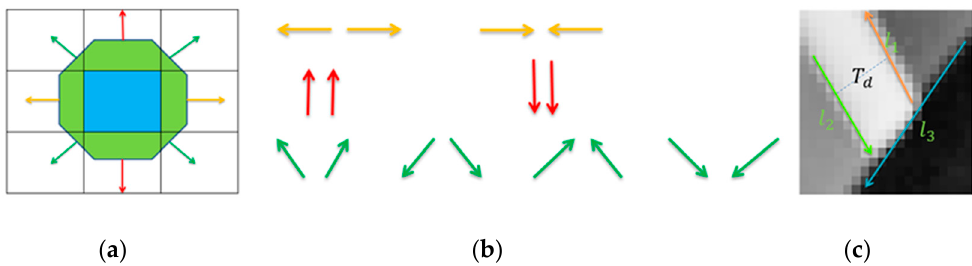
Figure 4. The gradient symmetry of points and line segments. ( a ) Gradient direction of a point; ( b ) the eight types of point gradient direction symmetry; ( c ) the gradient symmetry of line segments.